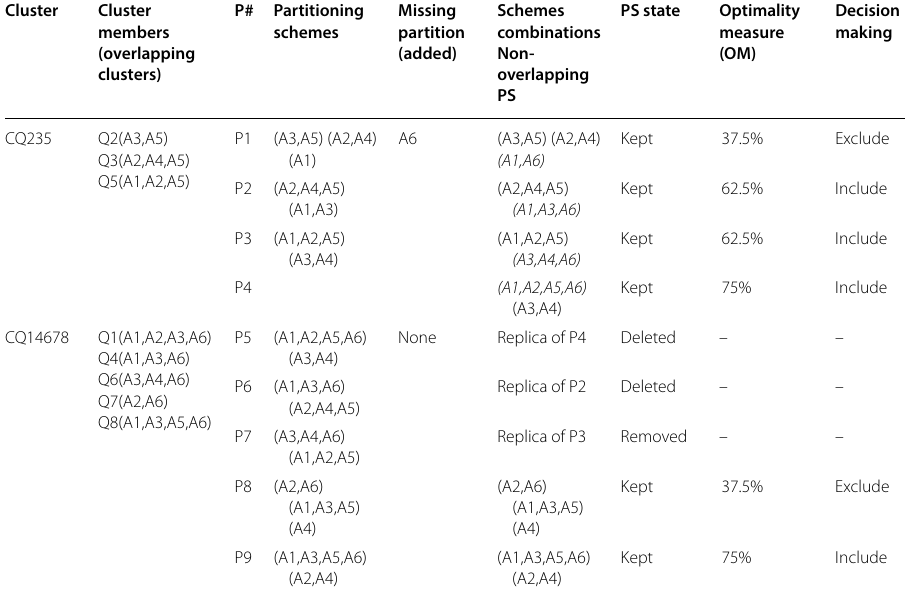
Table 11 Refinement process